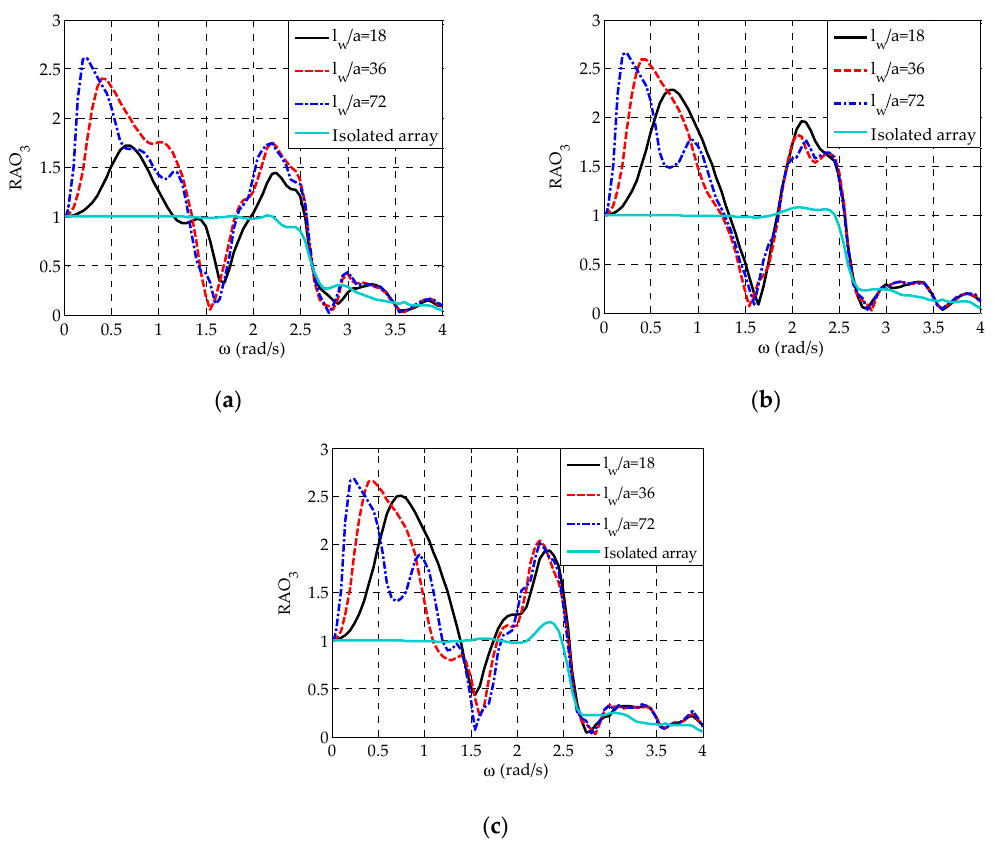
Figure 11. Effect of 𝑙 (cid:3050) /𝑎 on 𝑅𝐴𝑂 (cid:2871) applied on the semi-immersed oblate spheroidal WECs for Figure 11. E ff ect of l w / a on RAO 3 applied on the semi-immersed oblate spheroidal WECs for c / a = 3 𝑐/𝑎 = 3 and 𝑙 (cid:3029)(cid:3032)(cid:3047) /𝑎 = 4 : ( a ) WEC1 and WEC5, ( b ) WEC2 and WEC4, and ( c ) WEC3. and l bet / a = 4: ( a ) WEC1 and WEC5, ( b ) WEC2 and WEC4, and ( c ) The effect of 𝑙 (cid:3050) /𝑎 on the mean power absorbed by the whole array is shown in Figure 12, where 𝑝(𝜔) is plotted as a function of 𝜔 for 𝑙 (cid:3050) /𝑎 = 18, 36 and 72 , as well as for the case of the